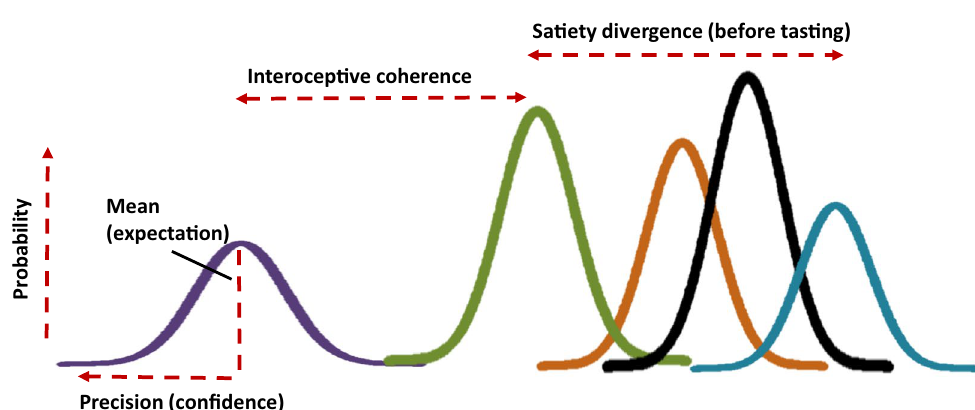
Figure 1. A schematic illustration of the present paradigm in the context of precision weighted inference. Under the principles of Bayesian inference and predictive coding, “top-down” predictions and “bottom-up” prediction errors are weighted by their precision or statistical confidence (i.e. inverse variance). Here visual and gustatory signals are combined to form an initial posterior satiety expectation: a high precision weighting of the gustatory signal (orange), relative to that of the visual signals (blue), enhances the gustatory influence on the posterior expectation (black). Note that as perception is a temporal process, Bayesian inference is reiterated as information from each measurement is added to the knowledge gained from all previous measurements— therefore this initial posterior expectation (black) will subsequently become the prior satiety expectation in anticipation of the next sensory input (i.e., how satiated I will feel once I have consumed this drink). In this example, this new multisensory prior (black) is precise, relative to the new interoceptive information (purple i.e., changes in blood glucose), and predominates subsequent perception (the updated posterior expectation: green i.e., how satiated I now feel). Therefore, the interoceptive coherence index (correlation between postprandial changes in blood glucose and hunger) indicated the degree to which individuals relied on interoceptive information in guiding their perception. Conversely, the satiety divergence index (absolute difference between expected and actual satiety) indicted the degree to which participants integrated prior beliefs.